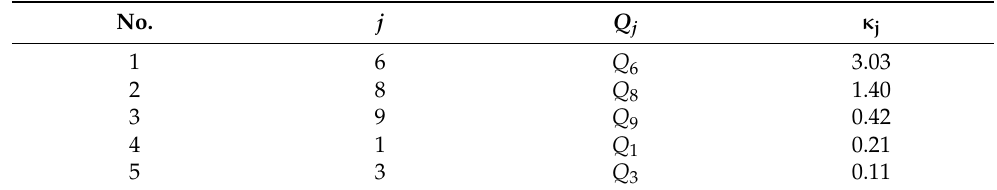
Table 14. A Ranking List of the Dominant Nodal Reactive Powers when the Index κ is Adopted as Criterion for Case 3.